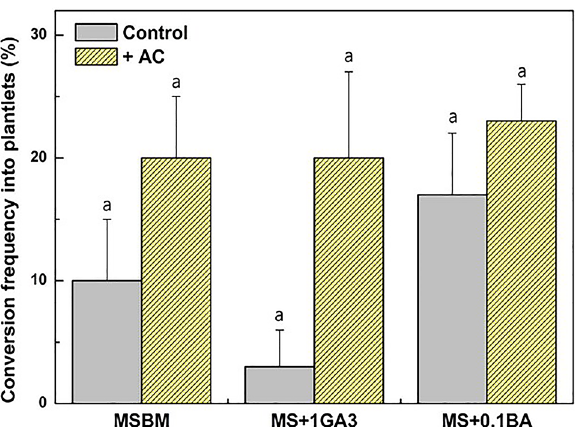
Figure 4. Effects of growth regulators (BA and GA 3 ) and activated charcoal (AC) on the conversion of somatic embryos into plantlets. The conversion frequency of somatic embryos for different combinations of treatments of 0.1 mg/L BA, 1 mg/L GA 3 and 0.2% AC. Each treatment consisted of 10 somatic embryos in a Petri dish and was repeated three times. Error bars represent SE (N = 30). Different lowercase letters on the bars